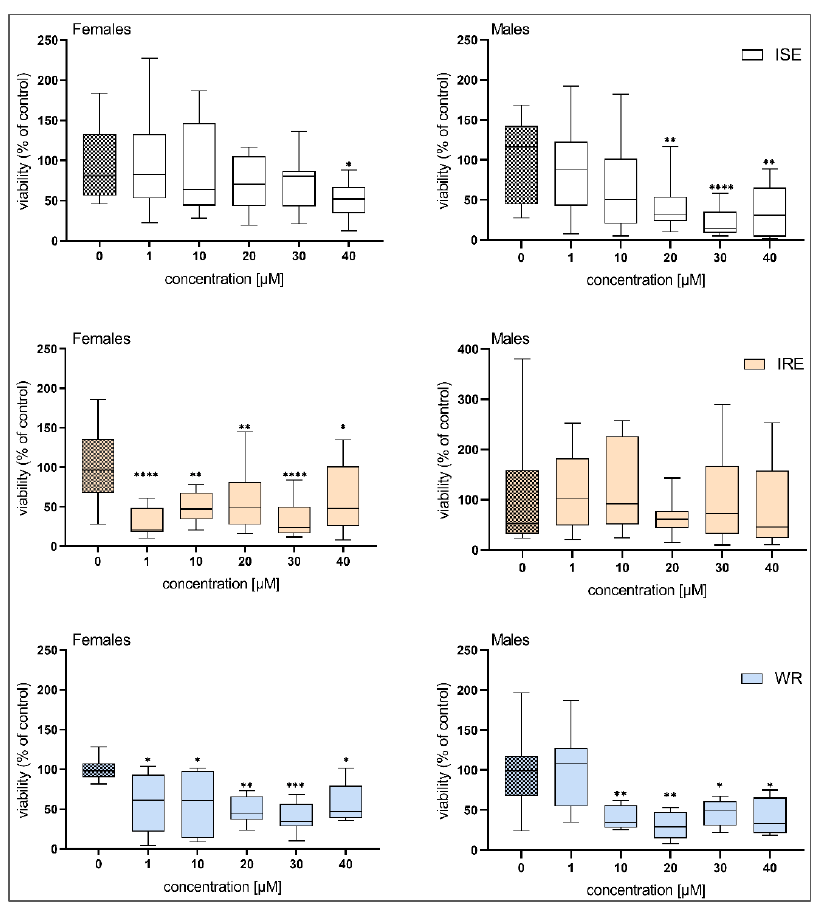
Figure 3. The effect of compound BLK127 on the viability of H. contortus adults from the ISE, IRE and WR strains after incubation (48 h). The data are expressed in percentage of viability of the controls (100%) and presented as a box plot ( n = 12). For statistical analysis, one-way ANOVA with Dunnett’s multiple comparison test was used. *, p < 0.05; **, p < 0.01; ***, p < 0.001; ****, p < 0.0001. Based on these results, we also performed experiments with BLK127 on two resistant strains (IRE and WR) of H. contortus . BLK127 significantly lowered the viability of females of the IRE and WR strains at a concentration of 1 µM, and in males of the WR strain at a concentration of 10 µM. For the males of the IRE strain, no significance was observed, probably due to the high variability of the results (Figure 3).